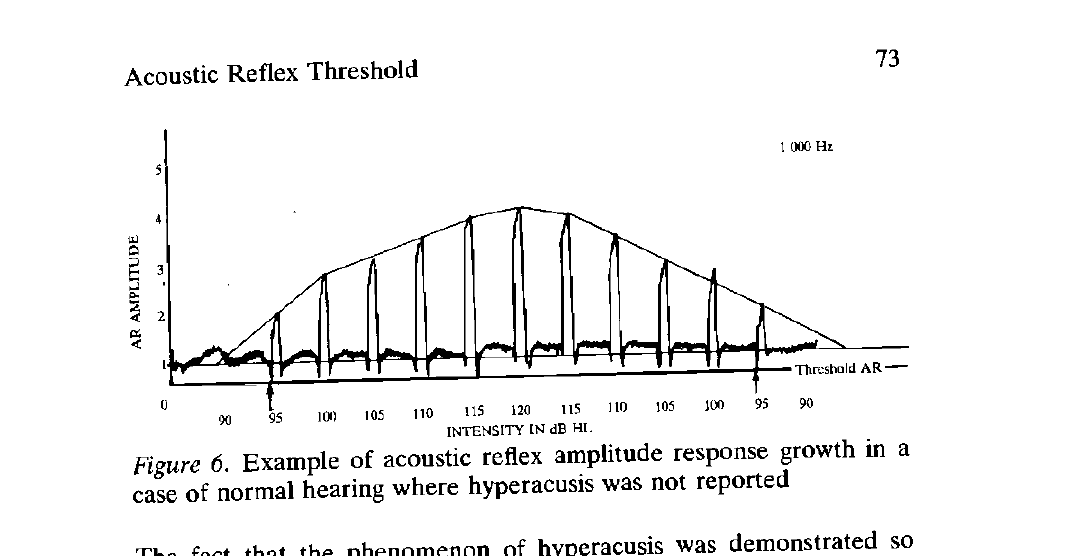
Figure 6. Example of acoustic reflex amplitude response growth in a case of normal hearing where hyperacusis was not reported The fact that the phenomenon of hyperacusis was demonstrated so vividly led the investigator to consider its analysis warranted however superficial. TABLE VII: The Frequency of Occurrence of Hyperacusis in the EG and CG Hyperacusis Present Absent Total 42 (100%) EG 0 42 (100%) 58 (100%) CG 15 (8,5%) 43 (91,5%) 100 Total 15 85